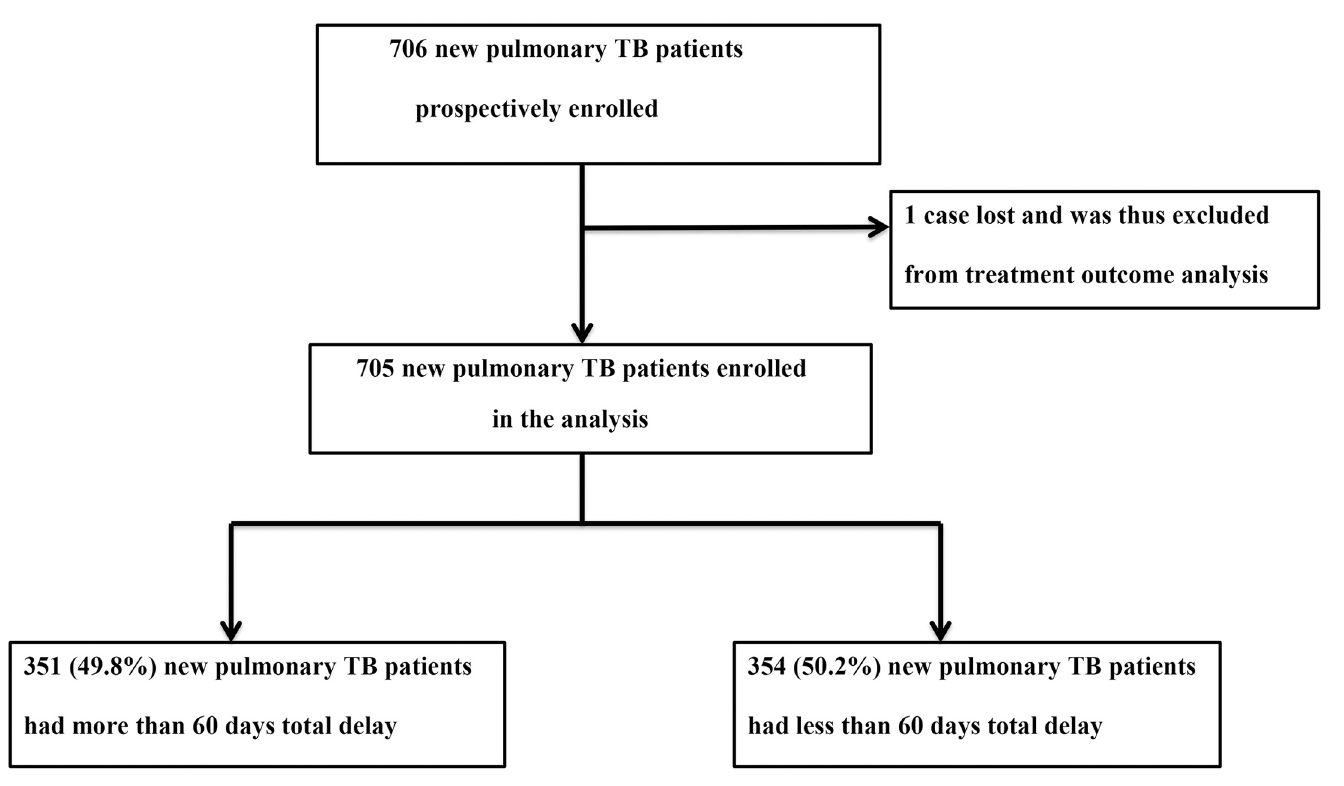
Fig 1. Study participants